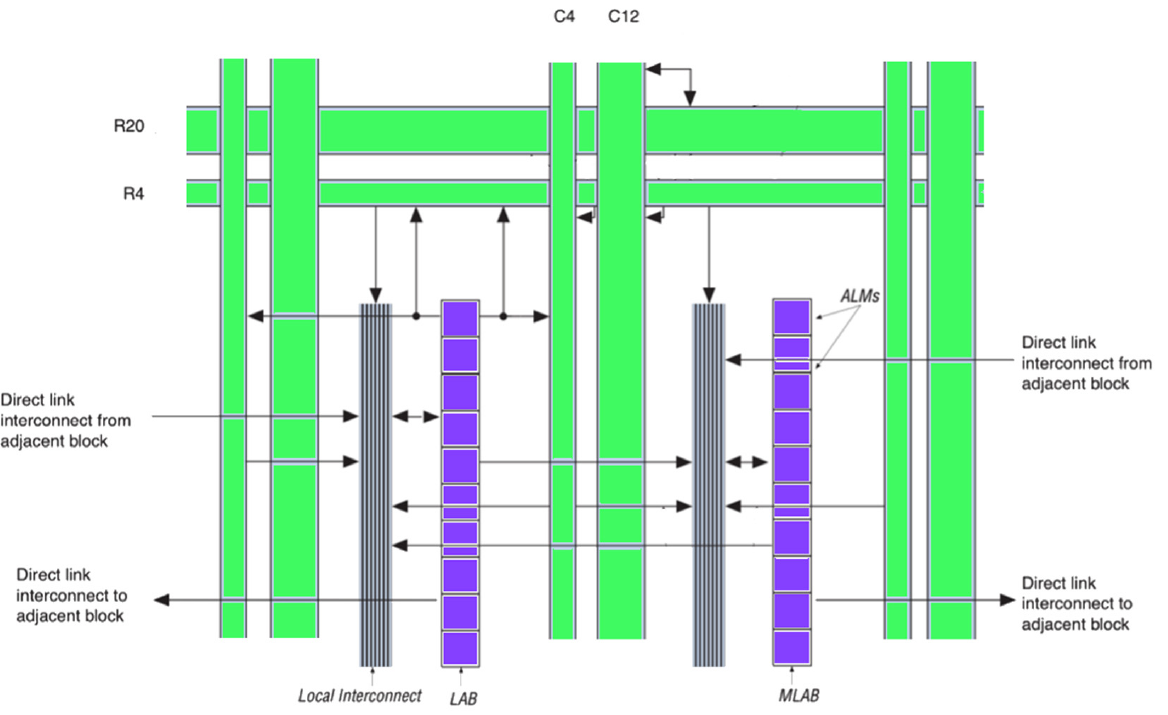
Figure 3. Stratix IV LAB structure and interconnects .